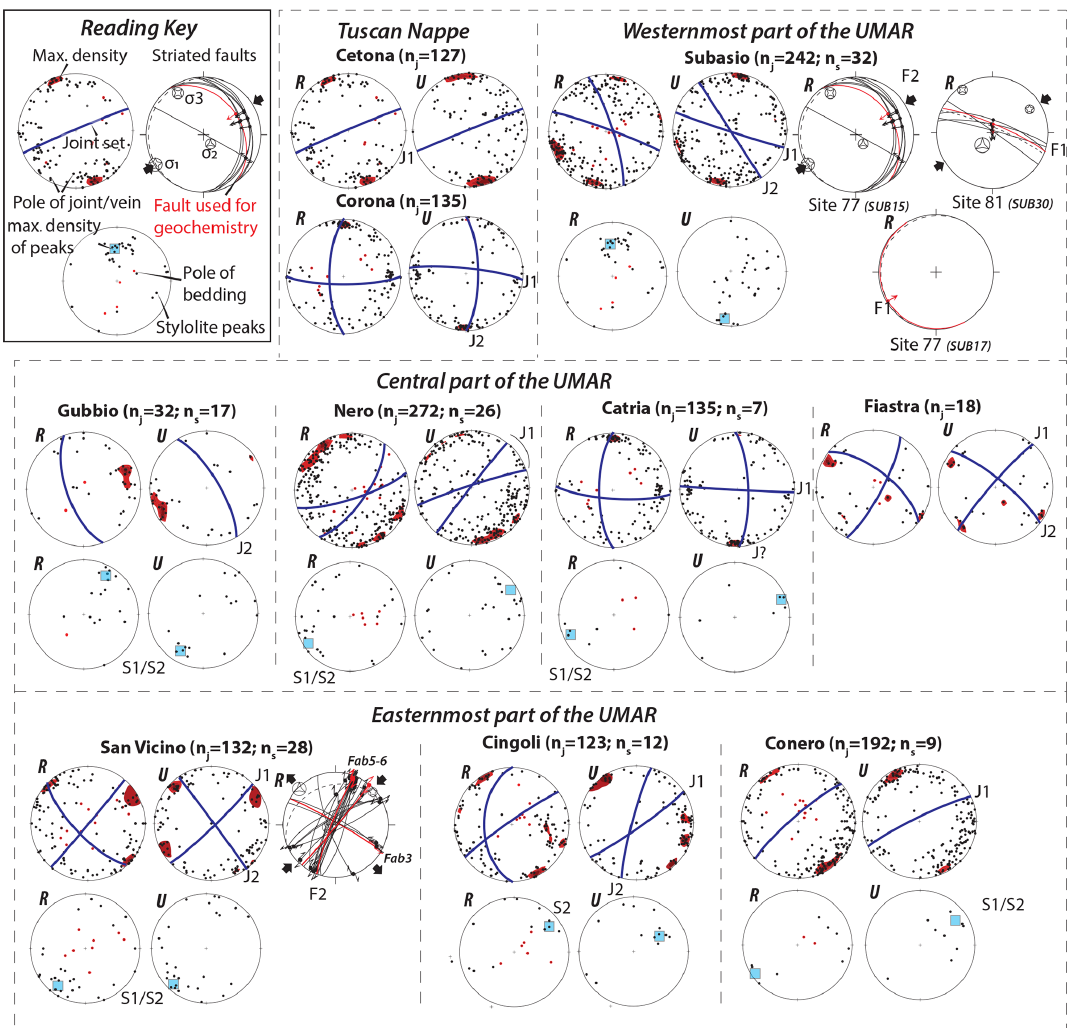
Figure 4. Poles of measured joints and veins and stylolite peaks projected on Schmidt stereograms, lower hemisphere, for the different structures. Data are projected in the current attitude of the strata (left, R ), with pole to bedding in red, and after unfolding (right, U ). Red areas represent highest density according to Fischer statistical analysis using the software OpenStereo, and main fracture set average orientations are represented as blue planes. For tectonic stylolite peaks, the blue square represents highest density according to Fischer statistical analysis. Striated fault inversion results are reported in the current attitude of the strata (bedding as dashed